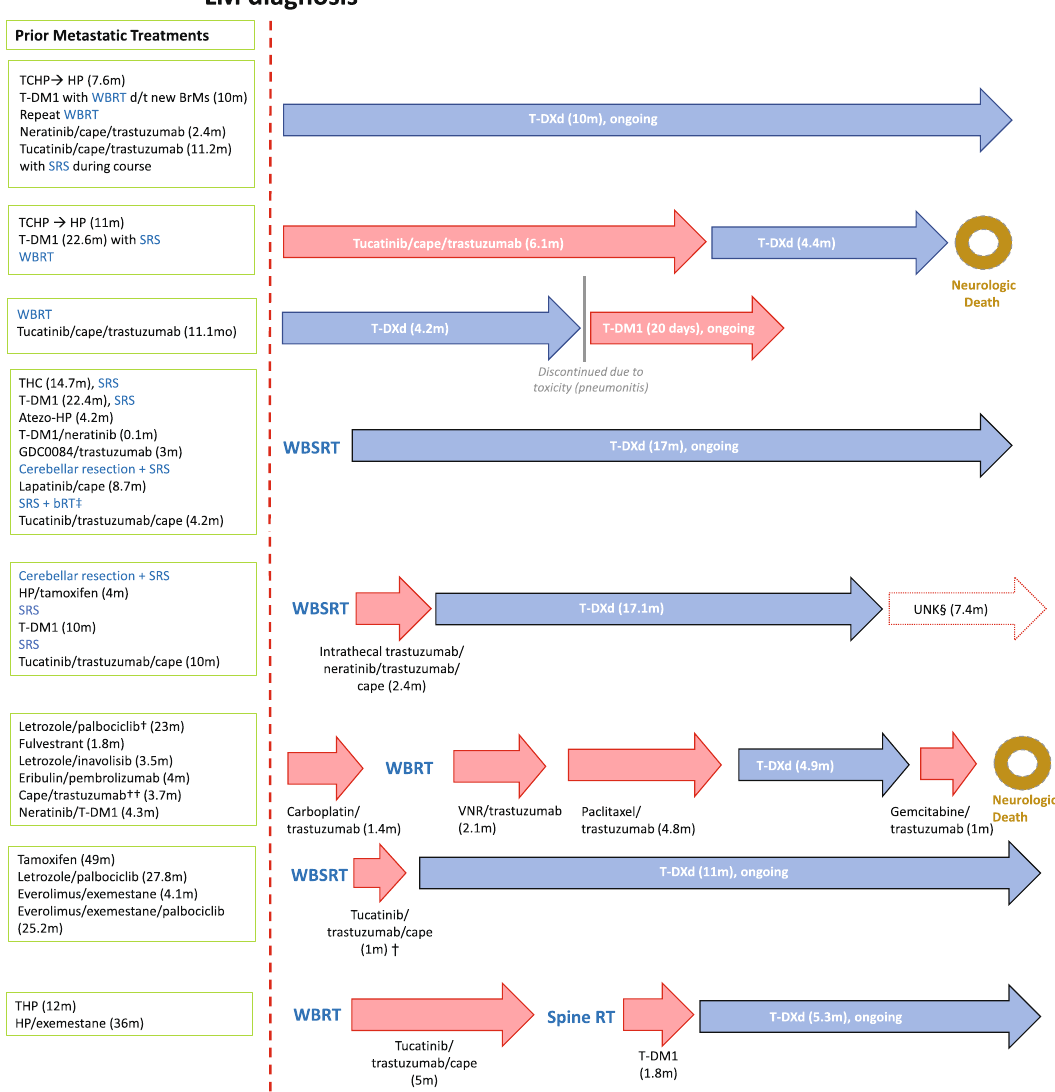
Fig. 1 Synoptic presentation of systemic and local treatments from metastatic disease diagnosis to LM course including T-DXd treatment. LM leptomeningeal disease, M months. TCHP trastuzumab, pertuzumab, carboplatin and docetaxel, THC trastuzumab, pertuzumab and docetaxel. HP pertuzumab and trastuzumab. Atezo-HP Atezolizumab, pertuzumab, and high-dose trastuzumab. T-DM1 trastuzumab emtansine. GDC0084 paxalisib. Cape capecitabine. WBSRT whole brain and spine radiotherapy. SRS stereotactic radiation therapy. WBRT whole brain radiation therapy. VNR vinorelbine. T-DXd trastuzumab deruxtecan. BrMs brain metastasis. ‡ bRT brachytherapy with radioactive seed implantation. † new biopsy showed HER2 in situ hybridization positive, UNK§, patient was given recommendation for further treatment, lost to follow-up; alive at data